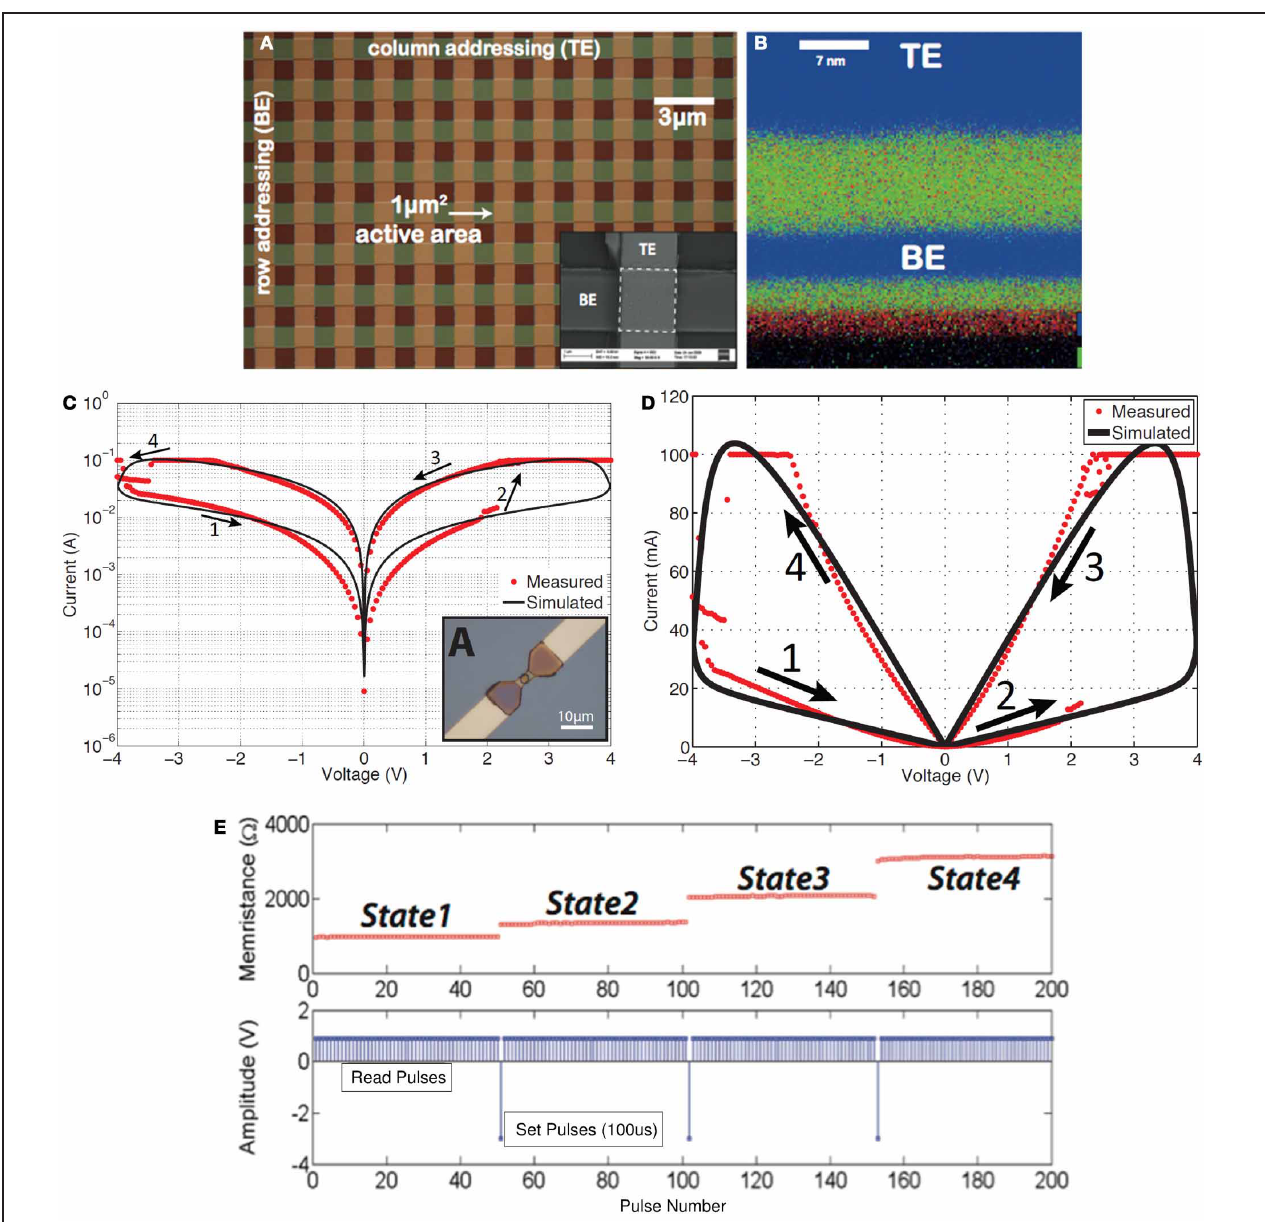
FIGURE 2 | Solid-state TiO 2 -based memristors fabricated at Imperial College London. (A) Microphotograph of a memristor cross-bar array, with a close-up SEM illustration of a single cell appearing in the inset of (A) . (B) CHEMI-STEM map of a lamella cross-section of one of the devices shown in (A) : blue denotes Pt (top and bottom electrodes) while green and red correspond to Ti and O 2 species (Prodromakis et al., 2012a). (C) Simulated and measured pinched hysteresis I-V